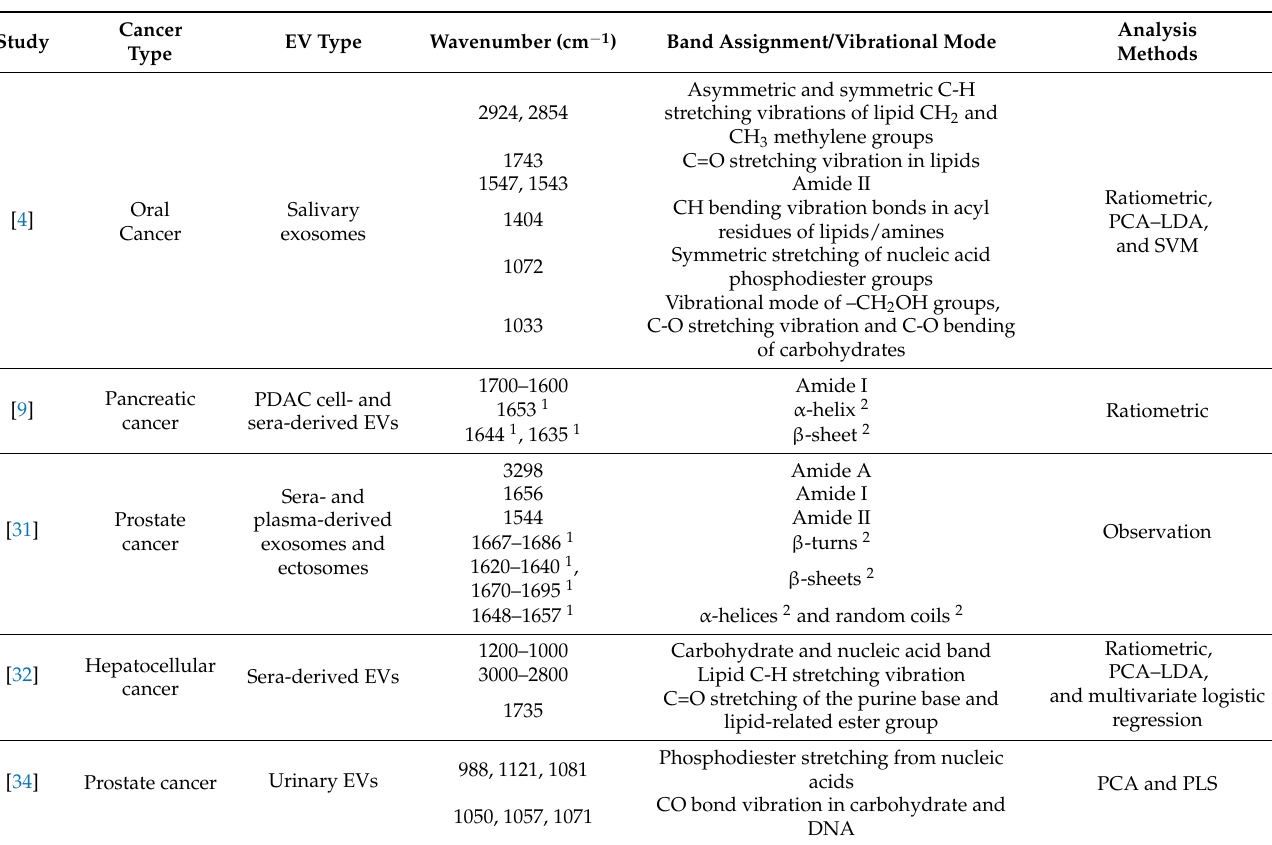
Table 4. A summary of the cancer-derived EVs studies using FTIR spectroscopy discussed in this